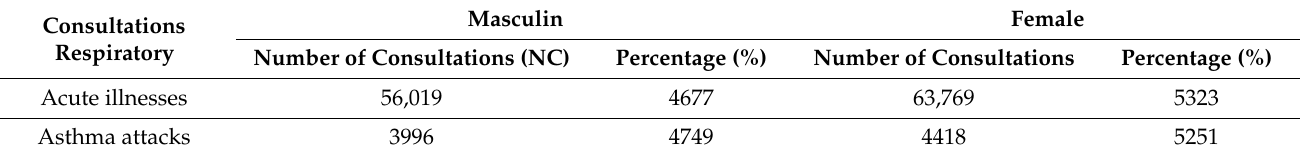
Table 2. Reasons for consultation in subjects aged five years and older by gender.